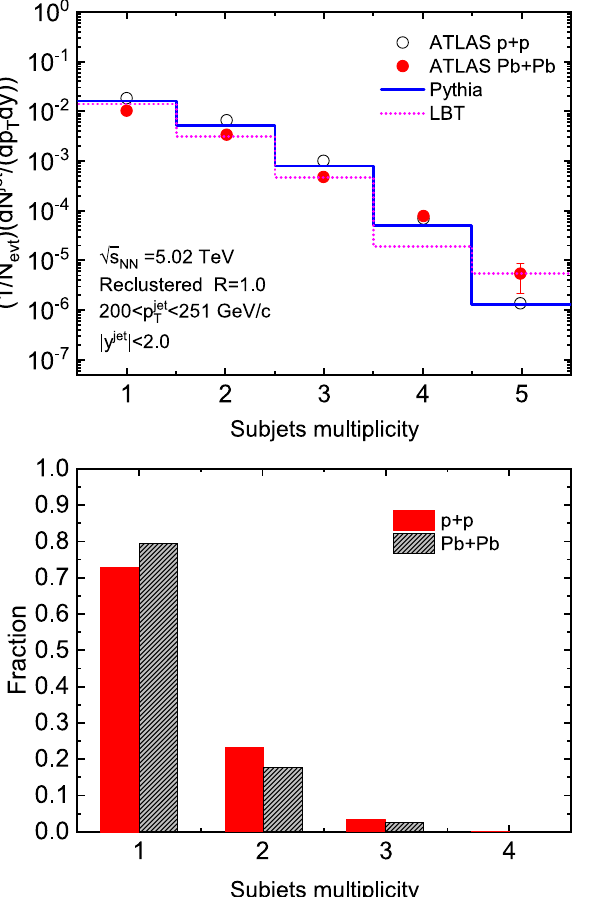
Fig. 3 Fraction transverse momentum loss of reclustered LR jets as well as inclusive jets as a function of jet transverse momentum in vac- uum (top panel). Ratio of transverse momentum loss of reclusteed LR jets with two subjets both before and after jet quenching as well as its leading subjet and subleading constituent to initial LR jet p T evaluated √ s NN = 5 . 02 TeV (bottom at as a function of the vacuum p jet T